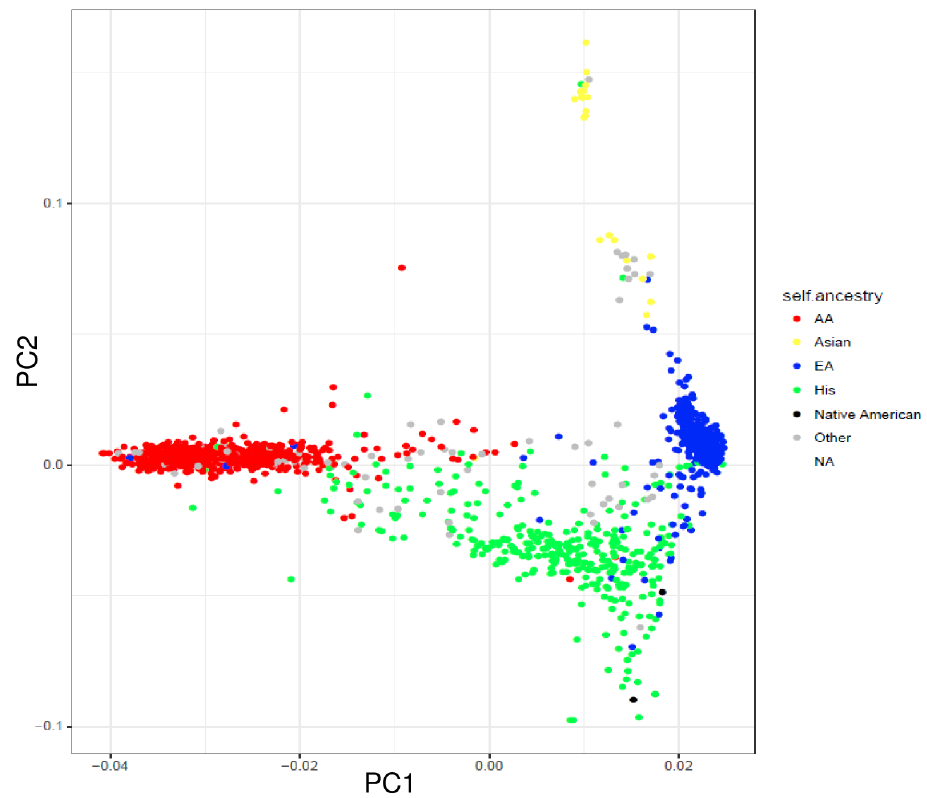
Fig 1. Scatter plot of the two main principal components based on filtered genome-wide genotype data of the original cohort. Each dot represents one individual colored by self-described ancestry. Color code: red: Africans; yellow: Asians; blue: Europeans; green: Hispanics; black: Native Americans; and gray: ‘others’. The corners correspond to high proportions of European, African, Asian and Native American ancestry.